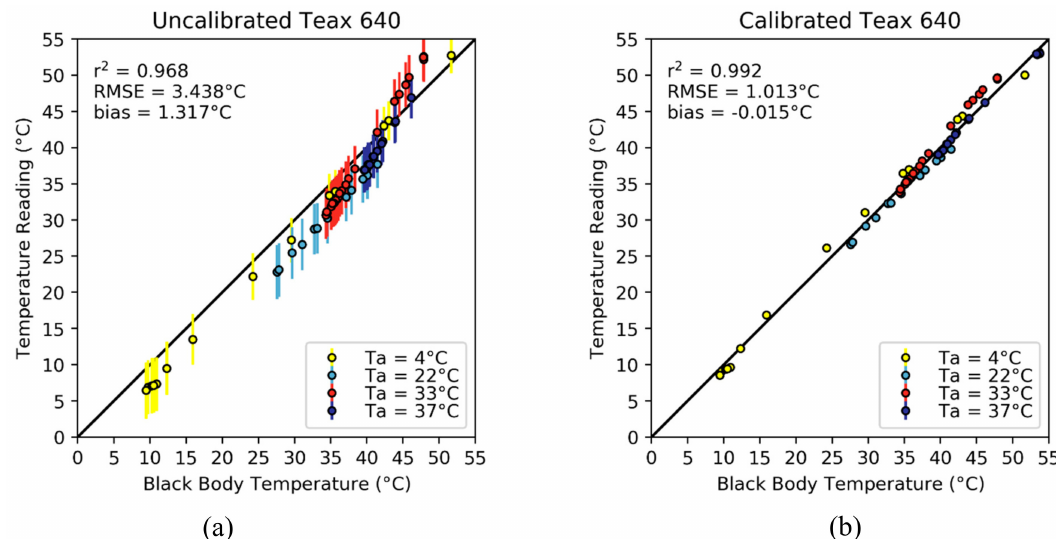
Figure 7. Scatter plot of the average temperature readings of the TeAx 640 camera before ( a ) and after ( b ) calibration. Error bars show the spread of the acquired temperature measurements that add up to the mean bias of the images. The error bars are three times the standard deviation of each sample as a measure of spread. The plots and the statistics were made from the evaluation dataset (n =